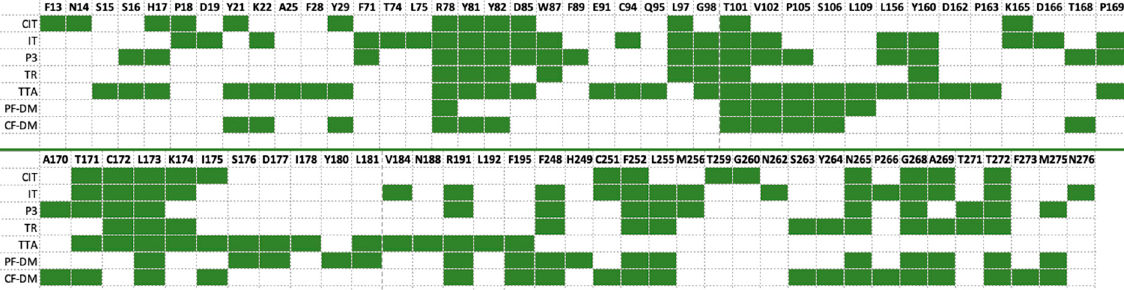
Figure 5. The changes in average distance measurements between C α atoms of the last five cyto- plasmic residues in TM3 (from Y3.51 to V(124)) and TM6 (from K6.30 to I6.34) for apo/unbound ( upper panel ) and CB148-complexed ( lower panel ) protein models. For colored graphs, please refer to the online version of this paper.